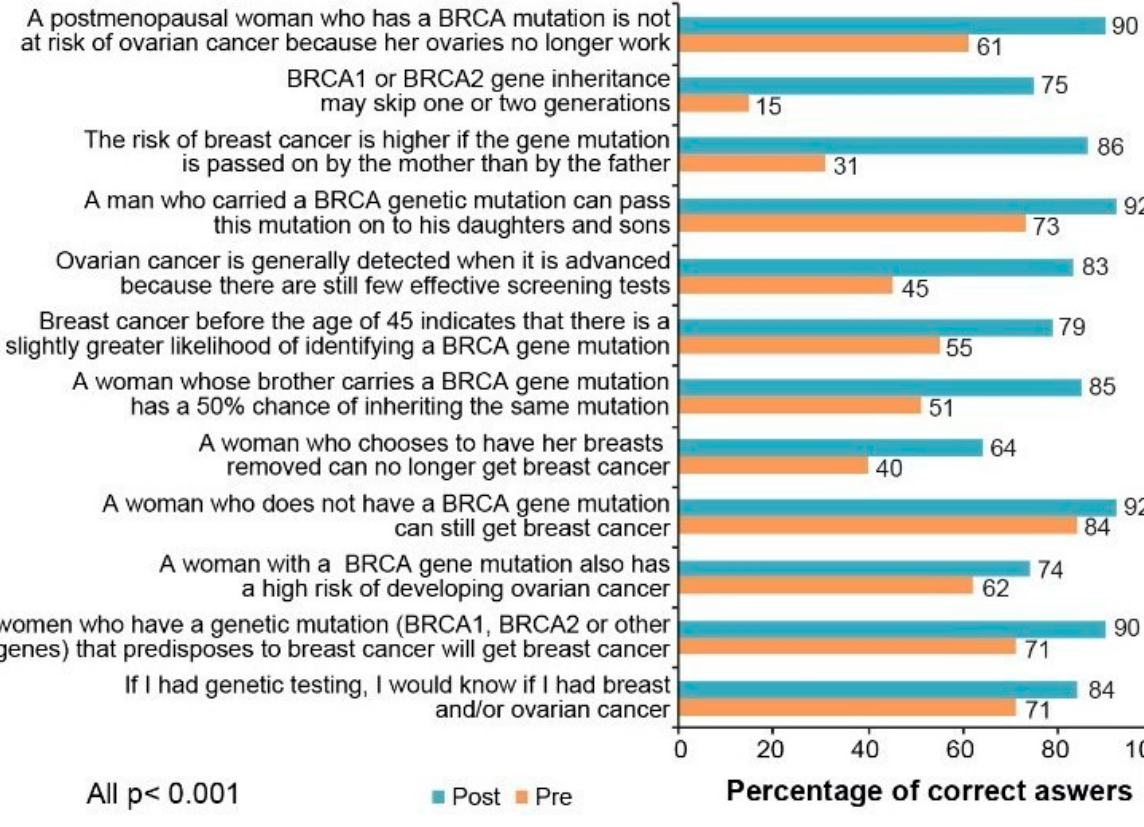
Figure 5. Knowledge Before and After the Counseling.